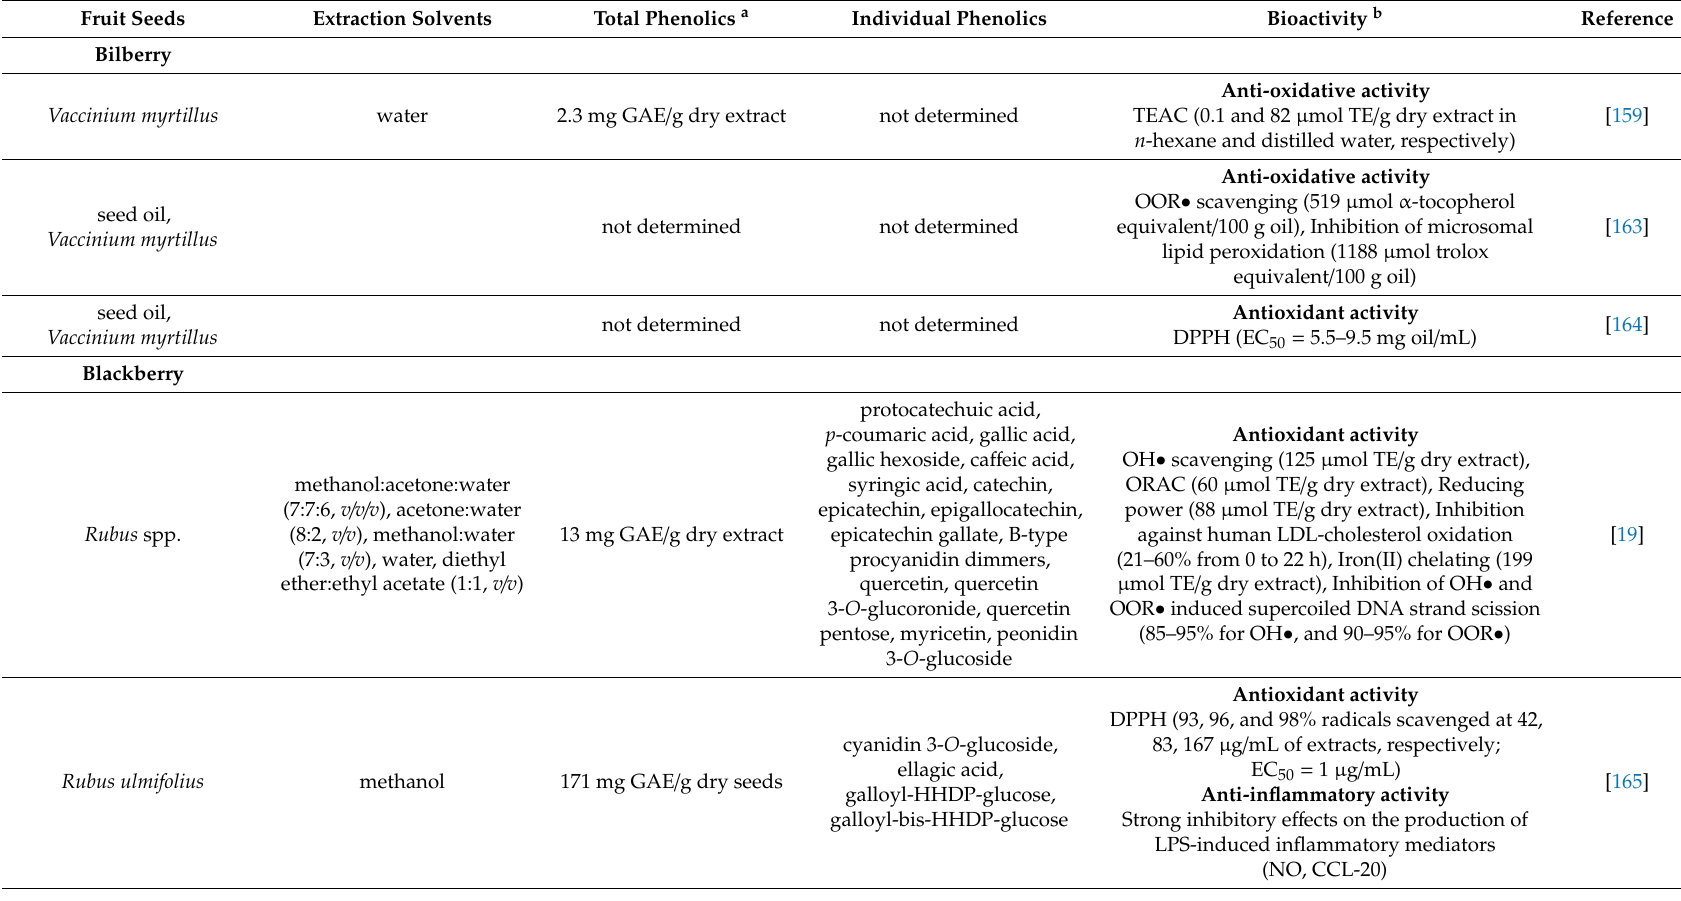
Table 2. Previous research on phenolic compounds and bioactivity of berry